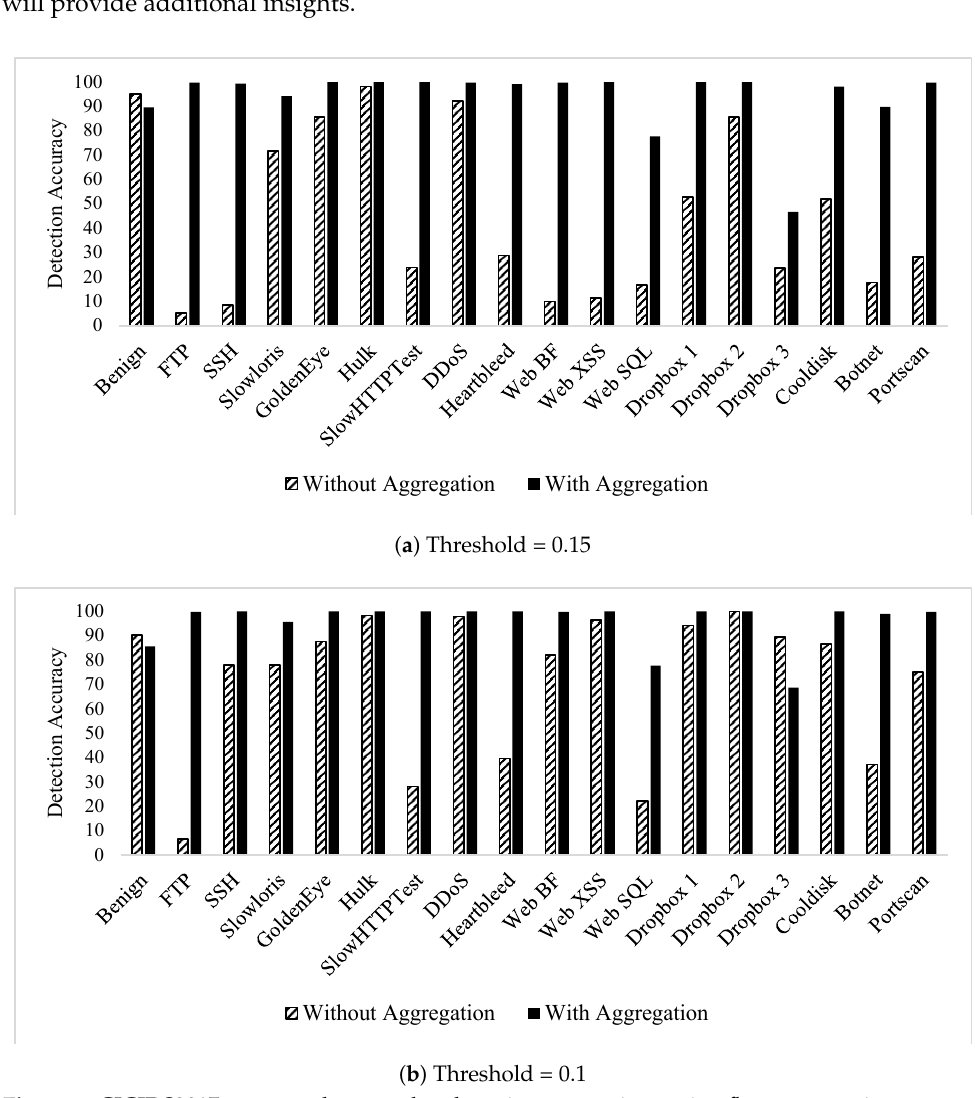
Figure 6. CICIDS2017 autoencoder zero-day detection comparison using flow